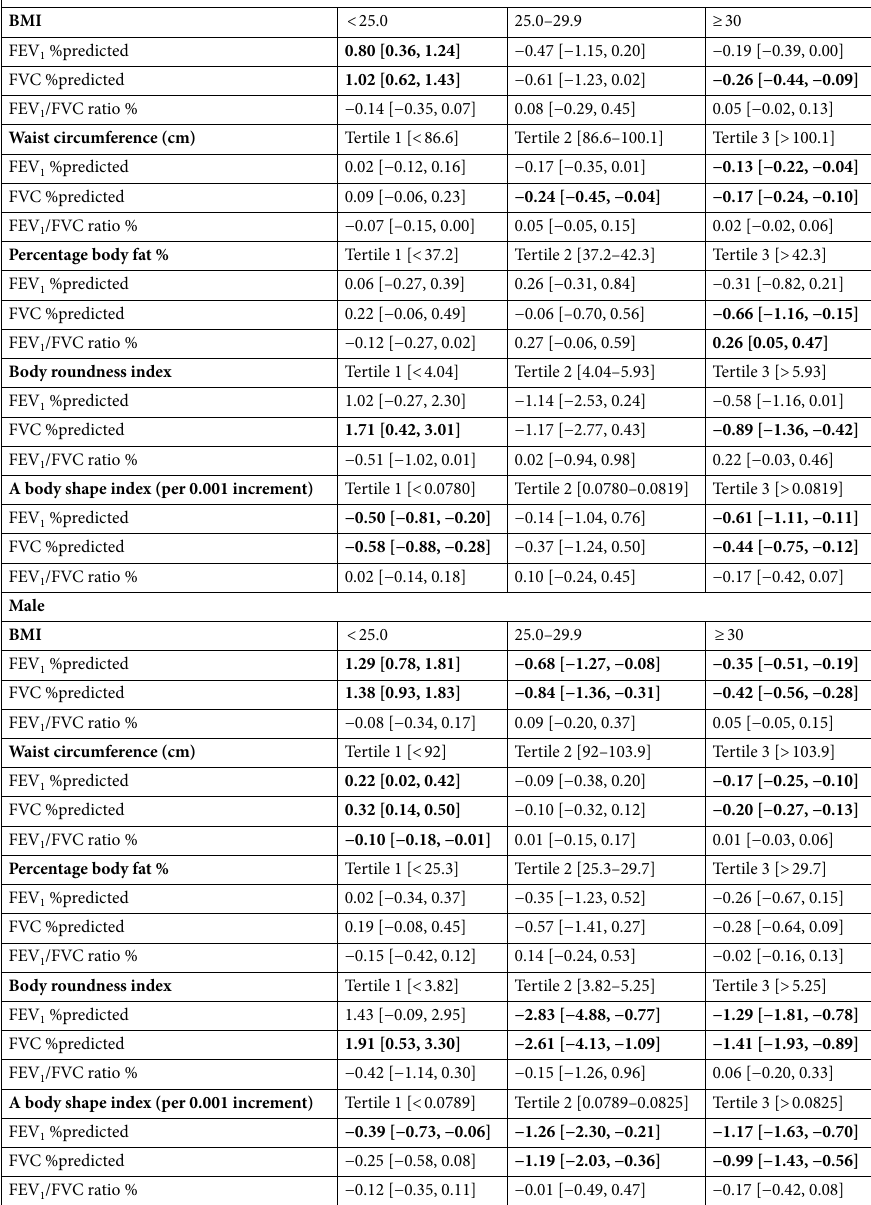
Table 3. Association between BMI, WC, PBF, BRI,ABSI and pulmonary function. Data were weighted estimates and expressed as mean [95% confidence interval]. Multiple linear regression was adjusted for age, race, education level, physical activity (MET score), smoking status. For example, for female participants with BMI < 25.0 kg/m 2 , BMI was associated increased FEV 1 %predicted value after adjusting for confounder